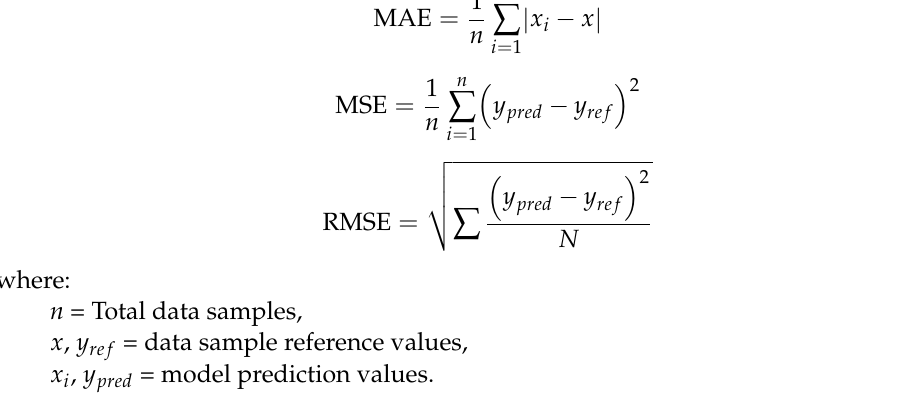
Table 6. Statistical checks of decision tree, random forest, AdaBoost, and bagging